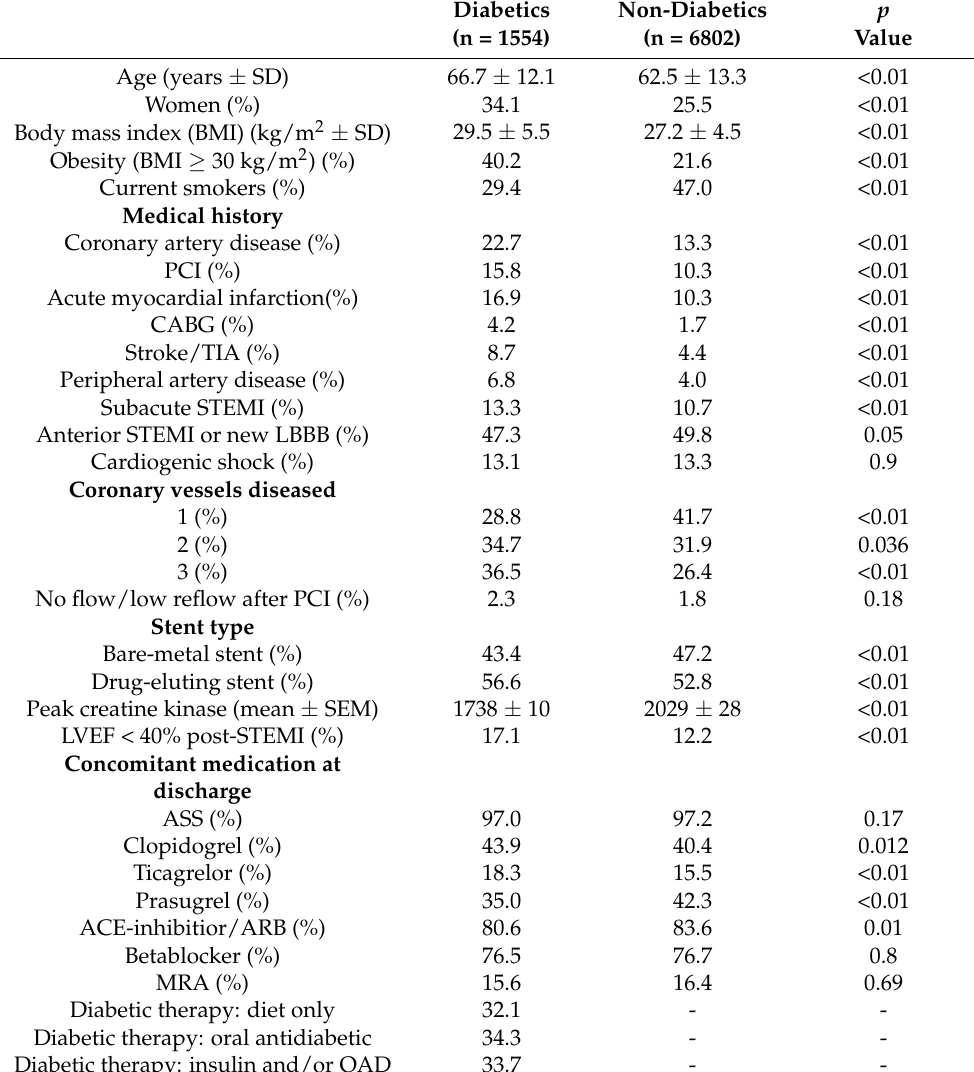
Table 1. Characteristics of diabetic vs. non-diabetic patients with